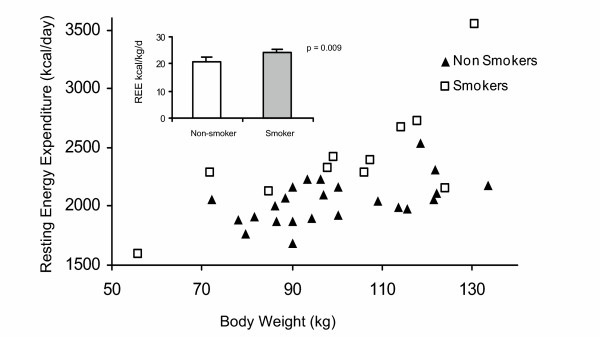
Resting energy expenditure is plotted against body weight. A linear relationship is seen for smokers and non-smokers. Inset shows that the mean unadjusted REE in smokers is higher by 3.26 kcal/kg/day (p = 0.009)